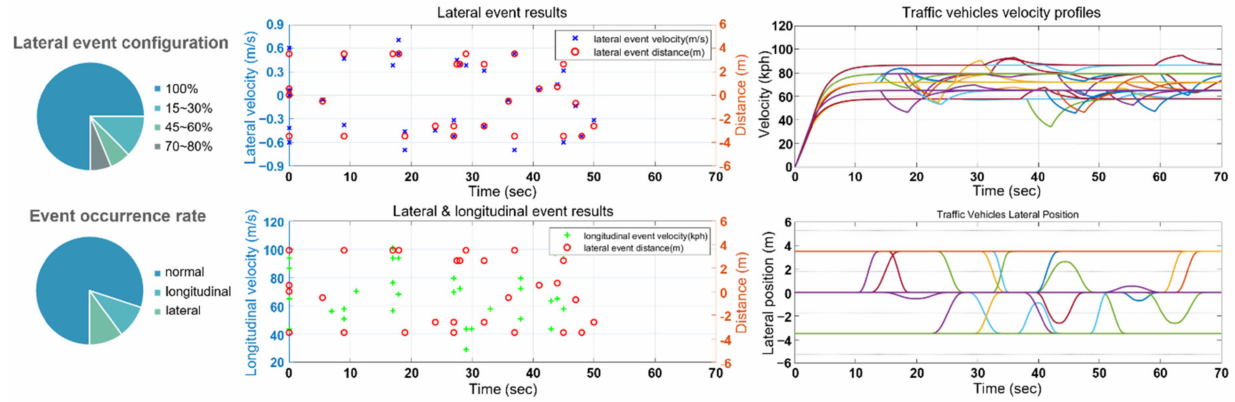
Figure 11. Traffic event generation